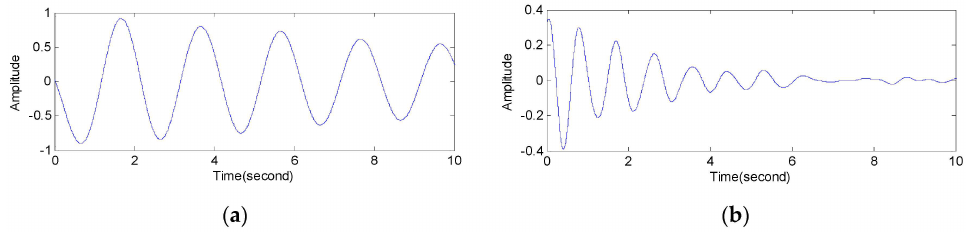
Figure 13. Fine analysis of the simulated signal with colored noise based on FSWT. ( a ) Frequency slice [0, 0.8] Hz; ( b ) Frequency slice [0, 0.8]